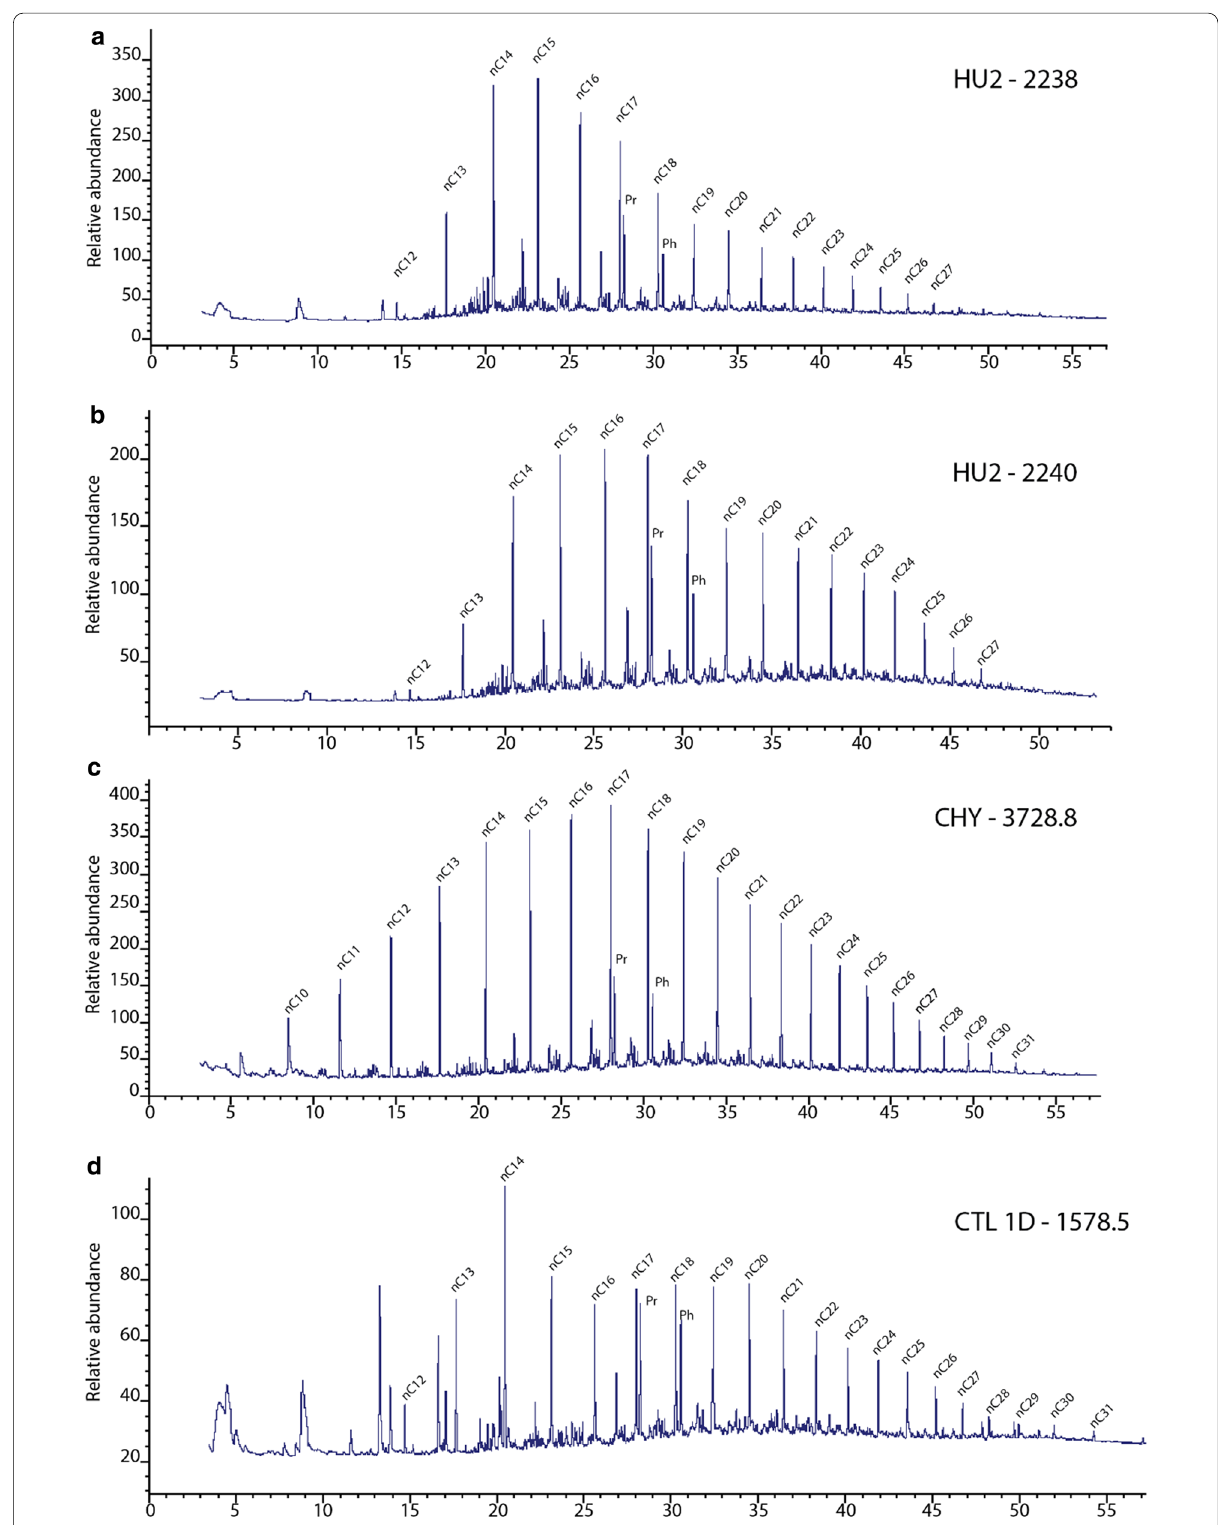
Fig. 6 Typical aliphatic fraction total ion chromatograms for the Toarcian unit of ( a , b ) Humilly-2 and ( c ) Chapeiry-1 well and the Carboniferous coal of ( d ) Chatillon-1D, ( e , g ) Charmont-1 and ( g , h )